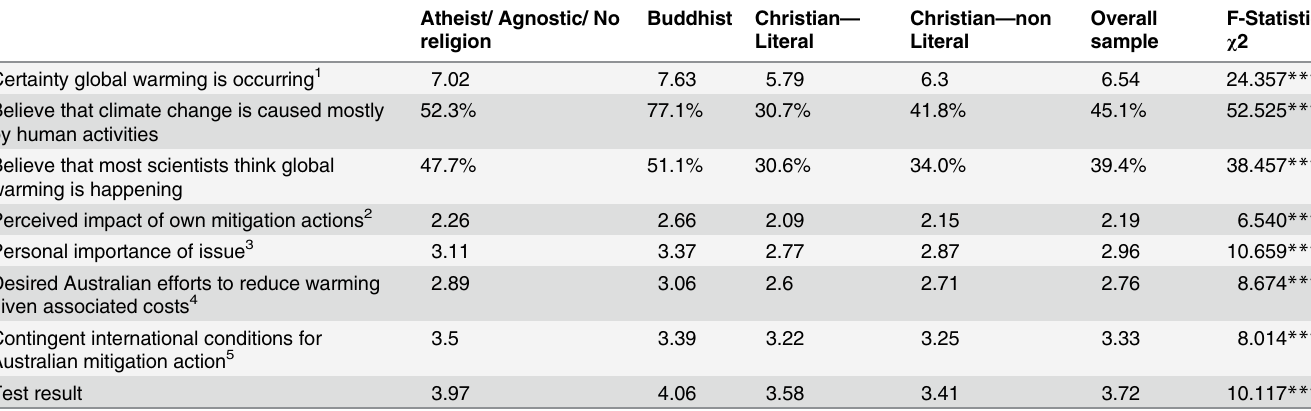
Table 3. Climate change beliefs across religious